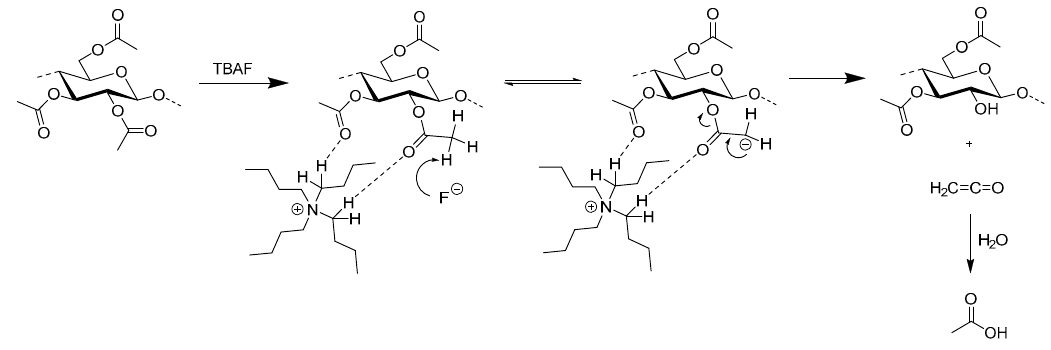
Figure 14. Proposed deacetylation mechanism of cellulose in the presence of TBAF; redrawn from [207,209].